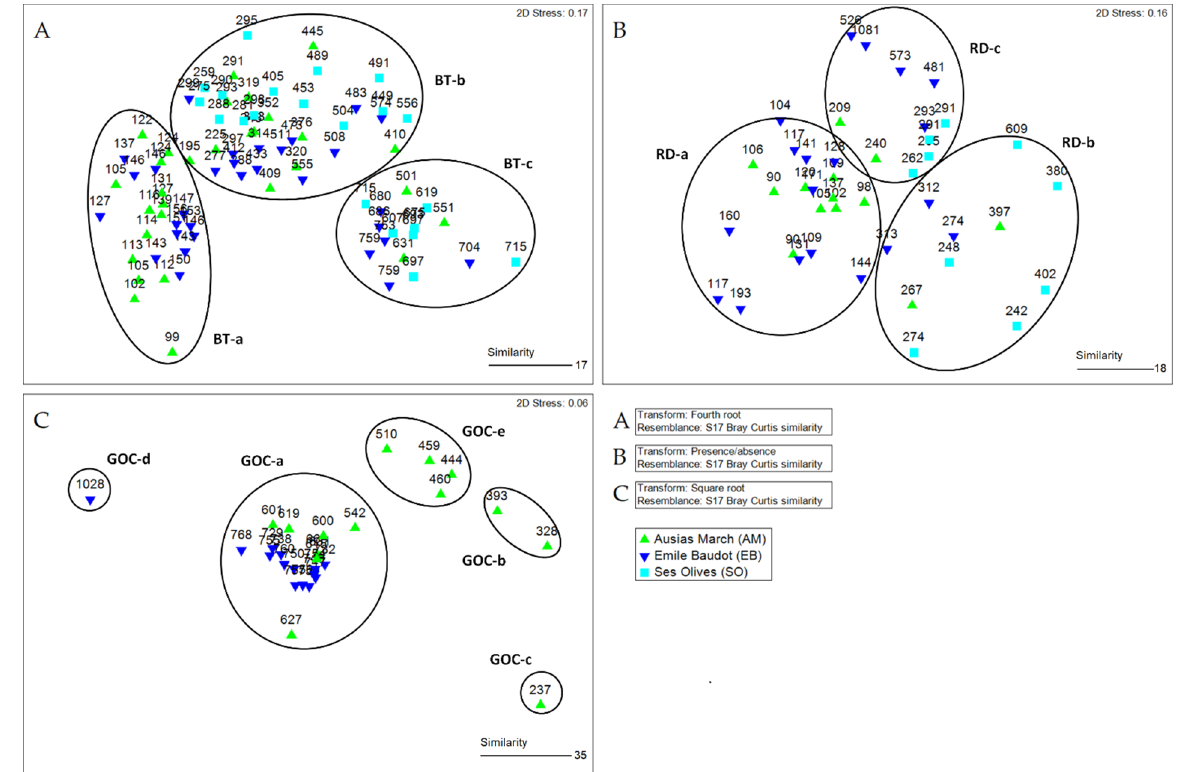
Figure 6. Multi-variant analysis of benthic assemblages, obtained in sedimentary and rocky bottoms of the Ses Olives (SO), Ausias March (AM) and Emile Baudot (EB) seamounts and adjacent area of the Mallorca Channel (Balearic Islands, western Mediterranean): ( A ) MDS and clusters at >17% similarity of epi-benthic species, identified from the analysis of beam trawl samples, in terms of standardized biomass (g/500 m 2 ), obtained in sedimentary bottoms; ( B ) MDS and clusters at >18% similarity of benthic species assemblages, identified from the analysis of presence/absence matrix from rock dredge samples, obtained in rocky bottoms; and ( C ) MDS and clusters at 50% similarity of necto-benthic species, identified from the analysis of experimental bottom trawl samples, in terms of standardized abundance (individuals/km 2 ), obtained in the fishing grounds adjacent to AM and EB. Labels and symbols correspond to sampling depth and area, respectively.